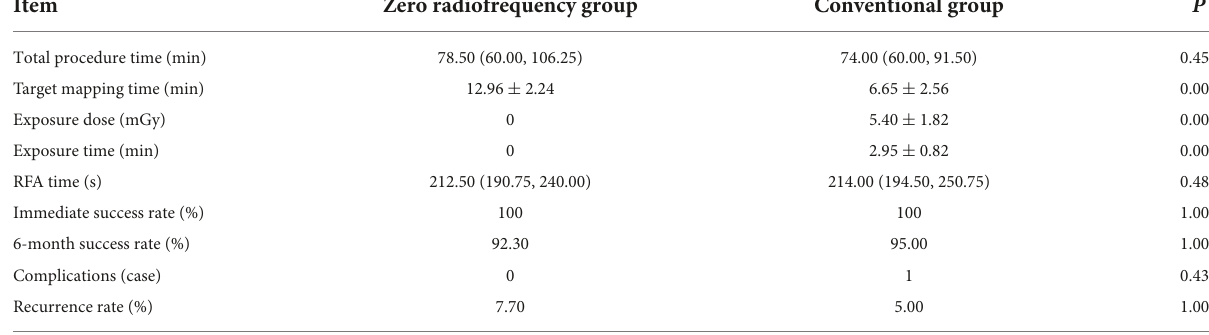
TABLE 3 Radiofrequency cardiac ablation parameters and follow-up